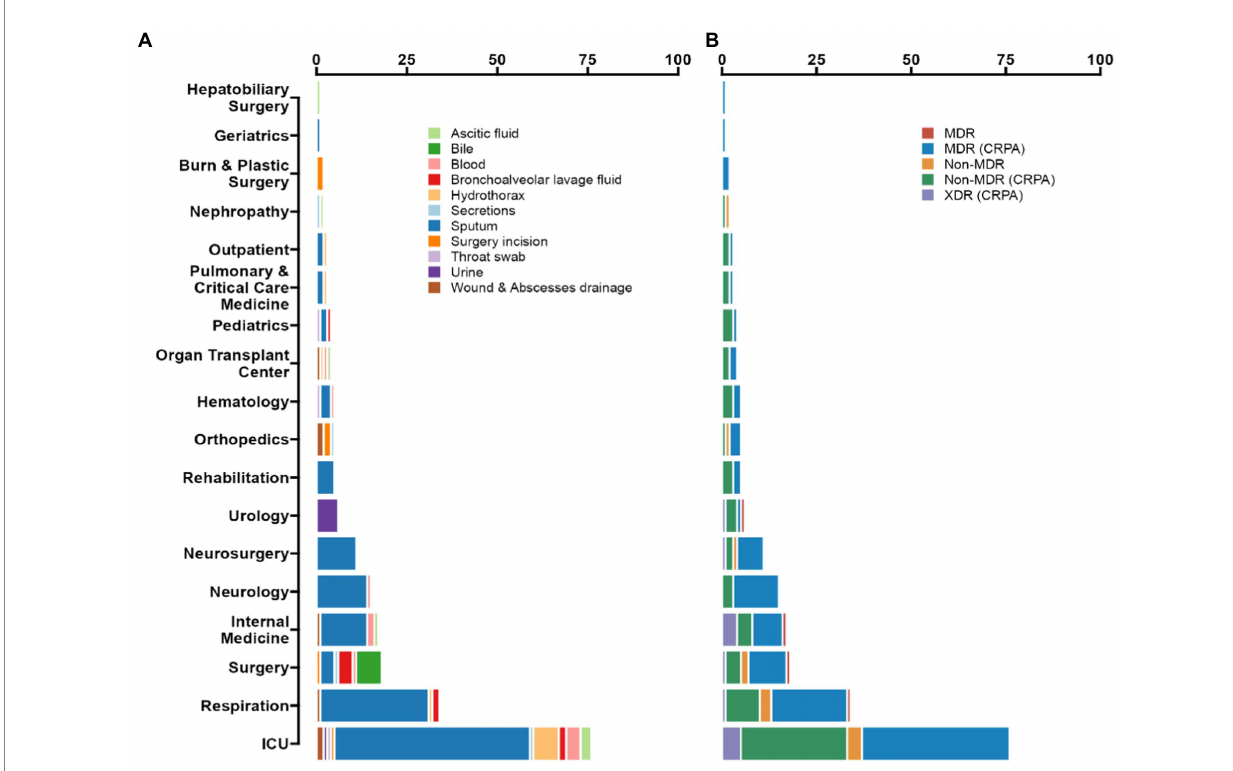
FIGURE 1 Prevalence of P. aeruginosa antimicrobial resistance in Guangdong province, China. (A) According to the ward distribution of the studied strains, the number of samples from ICU is 76 (35.85%), Respiratory Department samples numbered 34 (16.04%), and Neurology department samples numbered 15 (7.08%). Among all of the isolated strains, the most frequently isolated specimen was sputum (66.51%), then was hydrothorax (5.19%), blood (4.72%), and bronchoalveolar lavage fluid (BALF) (4.25%). (B) Up to 92.45% of the isolates were classified as CRPA, 55.19% as MDR (CRPA) and 6.13% as XDR